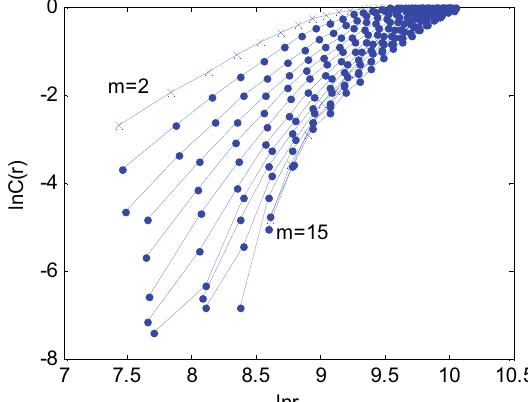
Fig.5. Relational diagram of